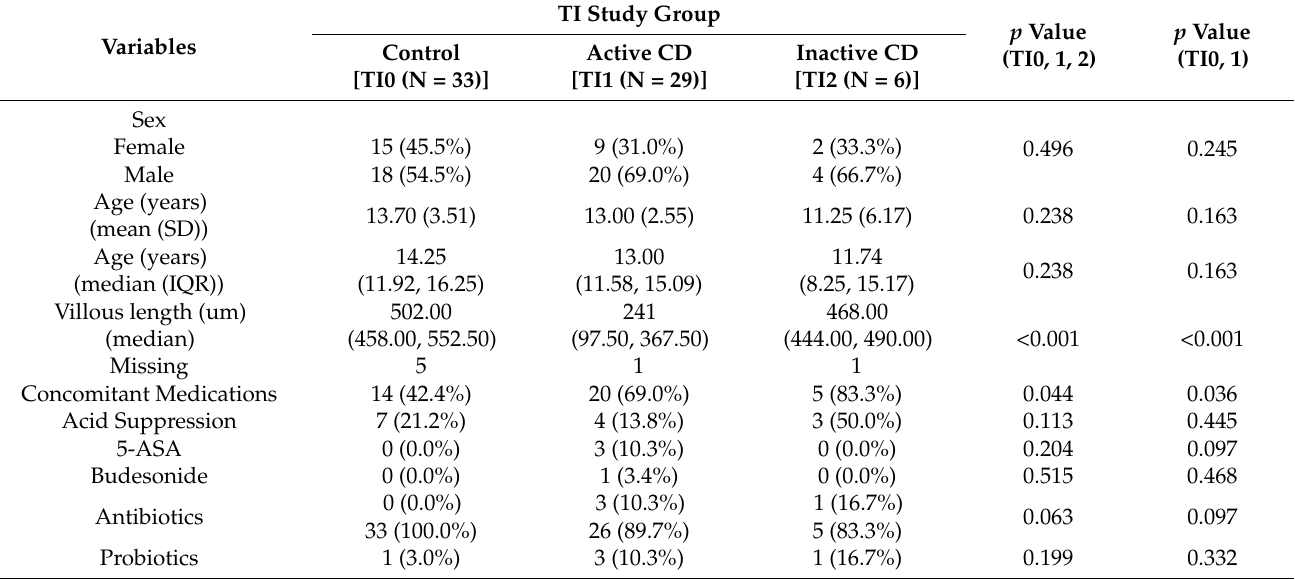
Table 4. Descriptive statistics for the TI sample population comprised of three study groups: Control (TI0), CD-active (TI1), and CD-inactive (TI2). SD—standard deviation, IQR—interquartile